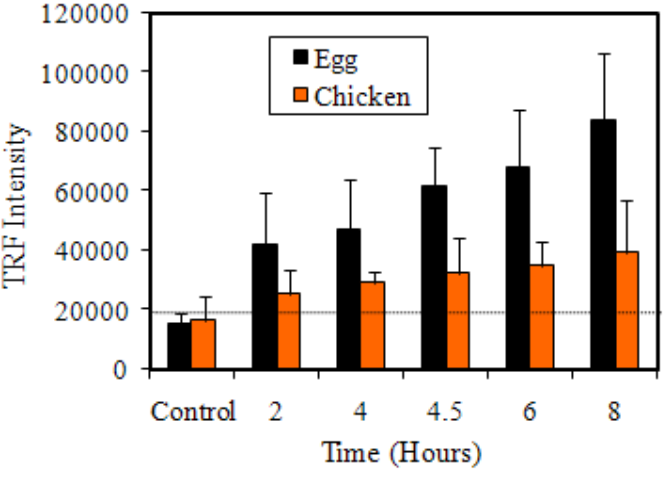
Figure 6. Detection of Salmonella Enteritidis spiked in egg and chicken by IMB-TRF. A total of 24 eggs were used for this experiment, four eggs for each time